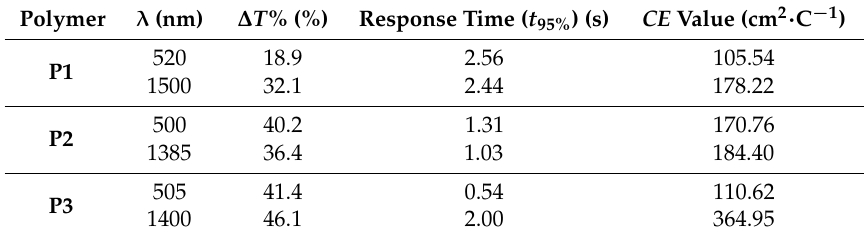
Table 2. Optical contrast ( ∆ T %), response time ( t 95% ) and coloration efficiency ( CE ) of three